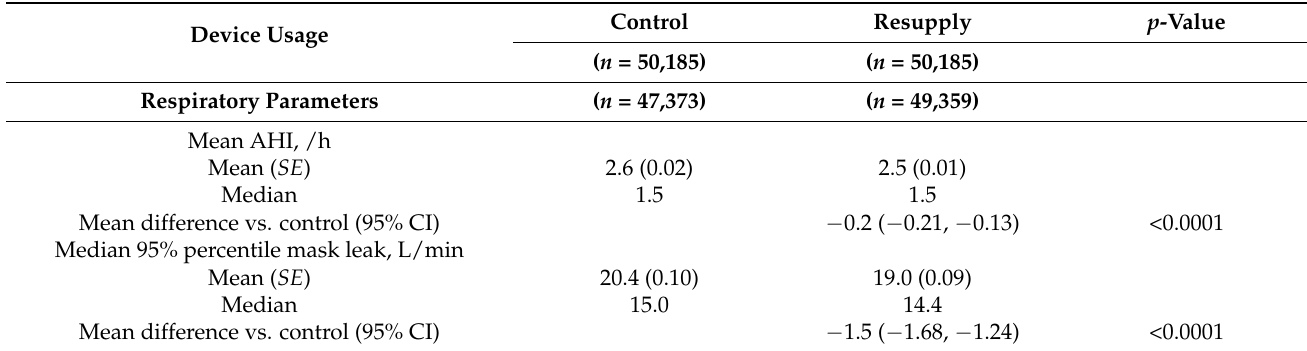
Figure 2. Overall probability of continuing with the positive airway pressure (PAP) therapy (“survival” of therapy) from days 91–360 in the control and resupply groups (primary analysis population). +Censored, patients whose therapy con- tinued after 360 days were censored at the 360 day time point.